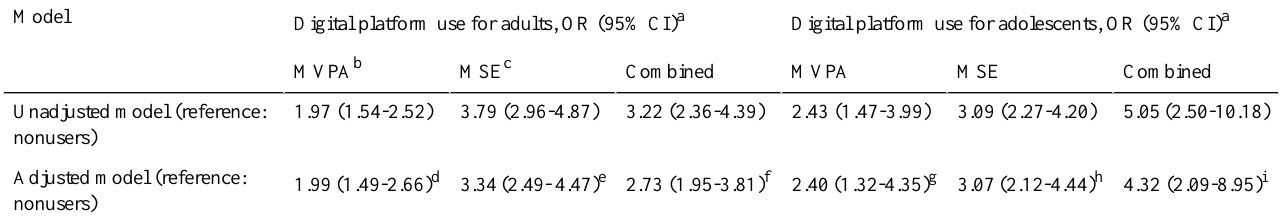
Table 3. Adjusted odds ratios (ORs) for the associations of physical activity guideline adherence and use of digital platforms.